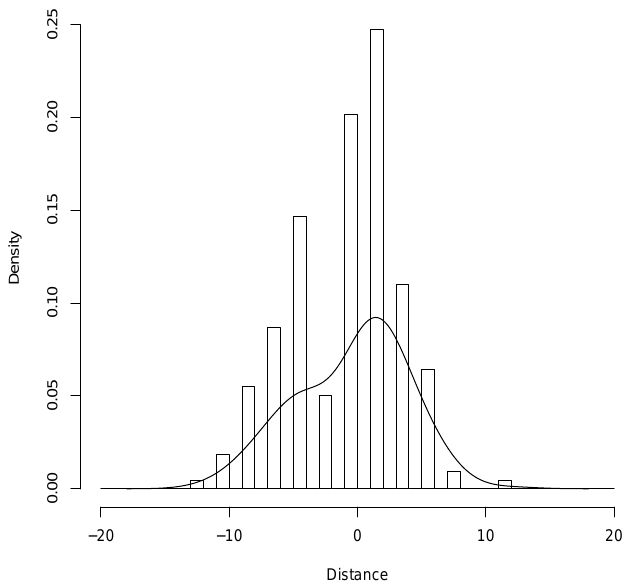
Figure 11. The variation of the precision of the localisation in the scenario